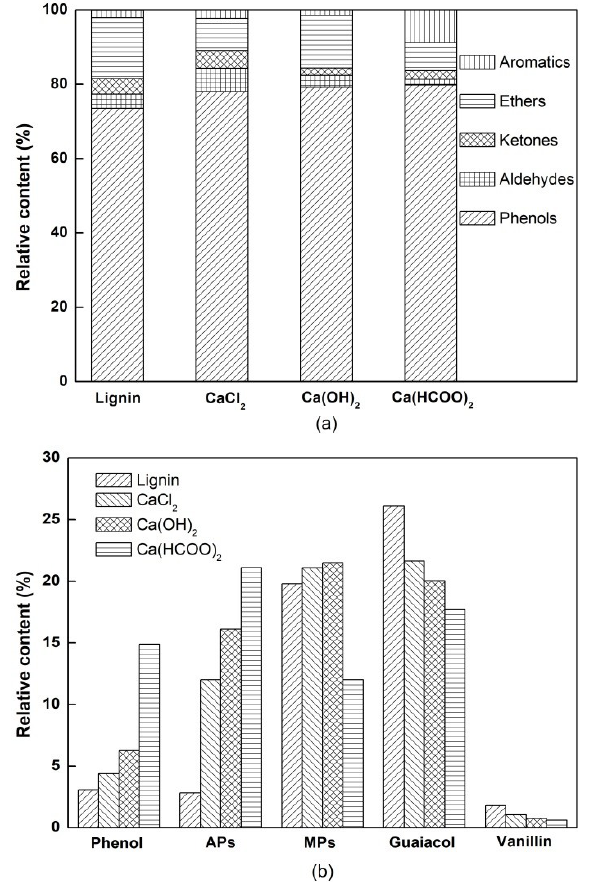
Figure 3. ( a ) Bio-oil composition and ( b ) contents of major phenols in the pyrolysis of lignin with